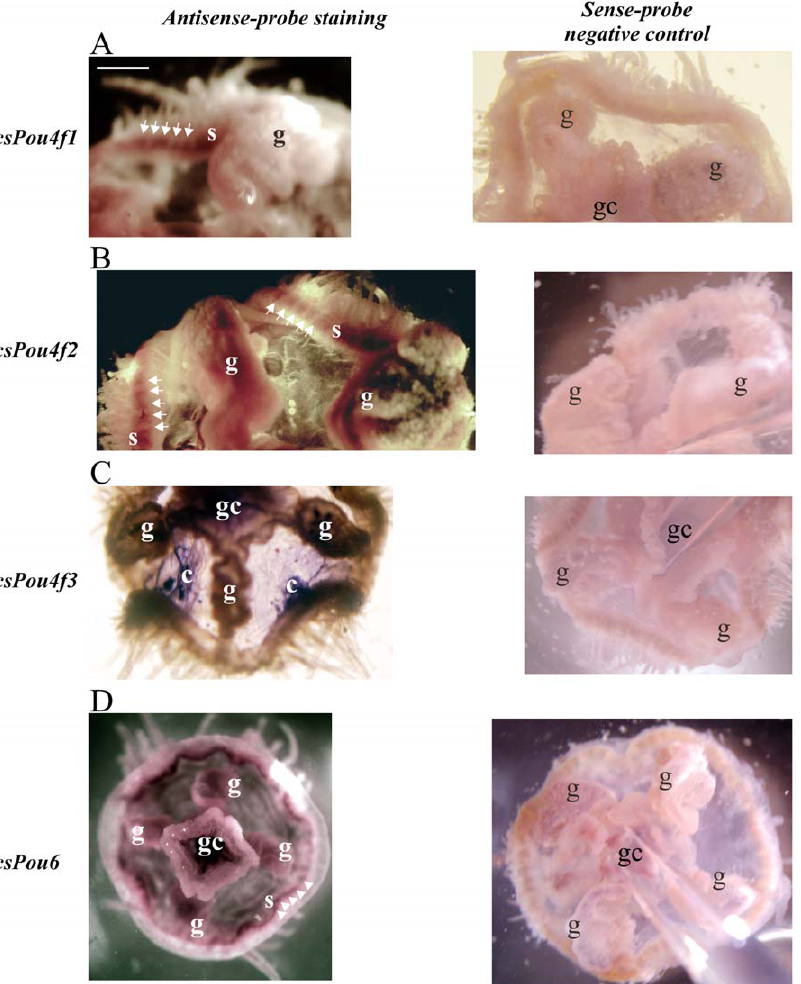
Figure 3. Expression of CraspedacustasowerbyiPou genes. Violet or blue coloring (depending on light intensity and conditions of the documentation process) shows sites of expression of particular genes. (A) csPou4f1 expression in statocysts (s), (B) csPou4f2 expression in statocysts and gonads (g), (C) csPou4f3 expression in the bell quadrant centers (c), (D) csPou6 expression in gonads, statocysts and gastric cavity (gc). Appropriate sense-probe negative controls are shown in the right column. A pipette tip was used for manipulation during the documentation and is present in some pictures. Scale bar (A, white) is in (A), (B) and appropriate negative controls 70 m m and in (C), (D) and appropriate negative controls 100 m m.